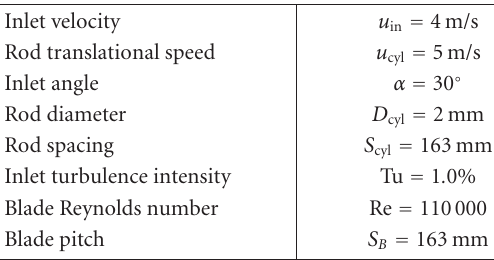
Table 1: Geometry and operation